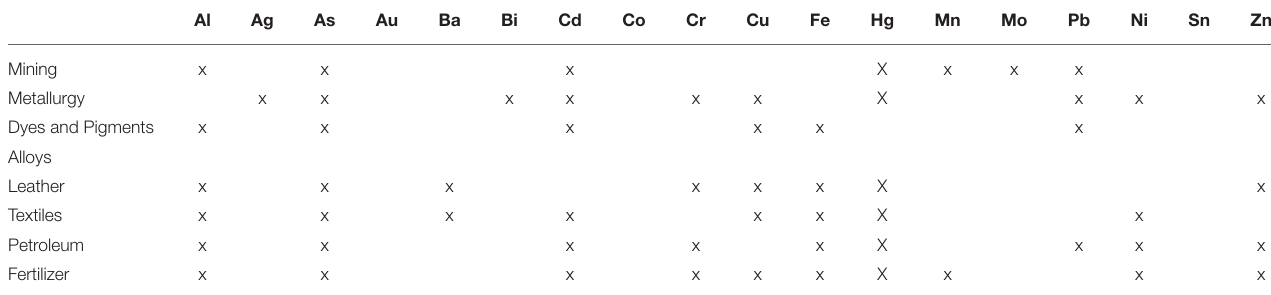
TABLE 6 | Occurrence of metals or their compounds in effluents from various industries (Source: Nagajyoti et al., 2010), Copyright 2018 Springer Nature. Al Ag As Au Ba Bi Cd Co Mining x x x Metallurgy x Dyes and Pigments x x Alloys